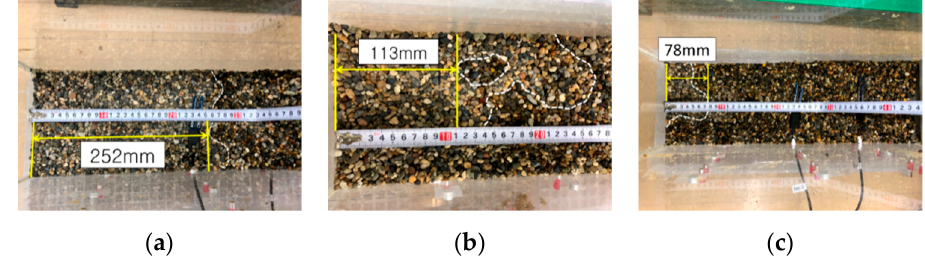
Figure 9. Measurement results of D1 for each case: ( a ) Case 1; ( b ) Case 2; ( c ) Case 3. Table 5. Measured and estimated values of diversion length, L D . Case No. Case